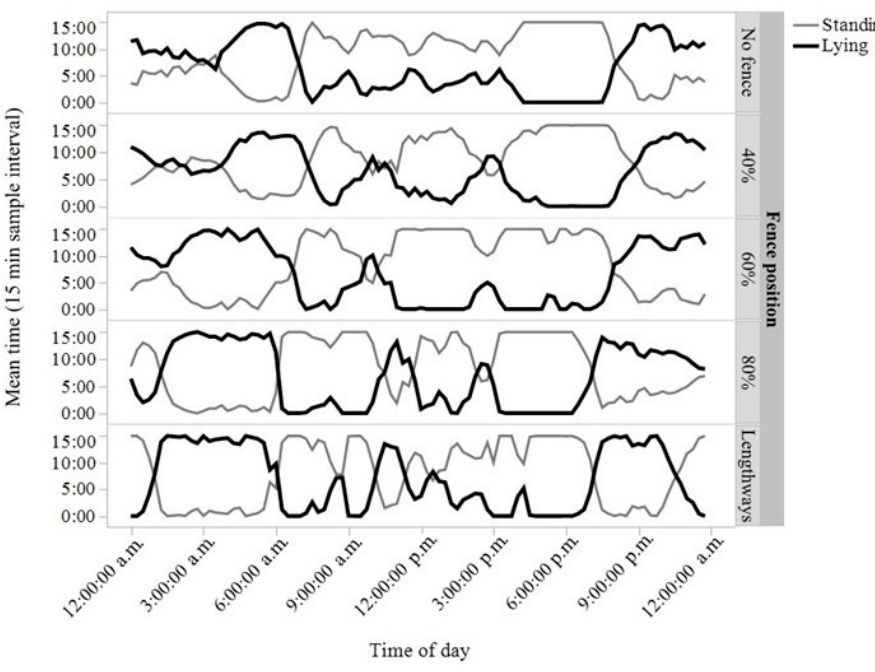
Figure 4. Mean time within 15-min sample intervals that cattle ( n = 6 heifers) were standing or lying across the day for each of the different positions of the virtual fence (no fence, 40%, 60%, 80%, and lengthways).